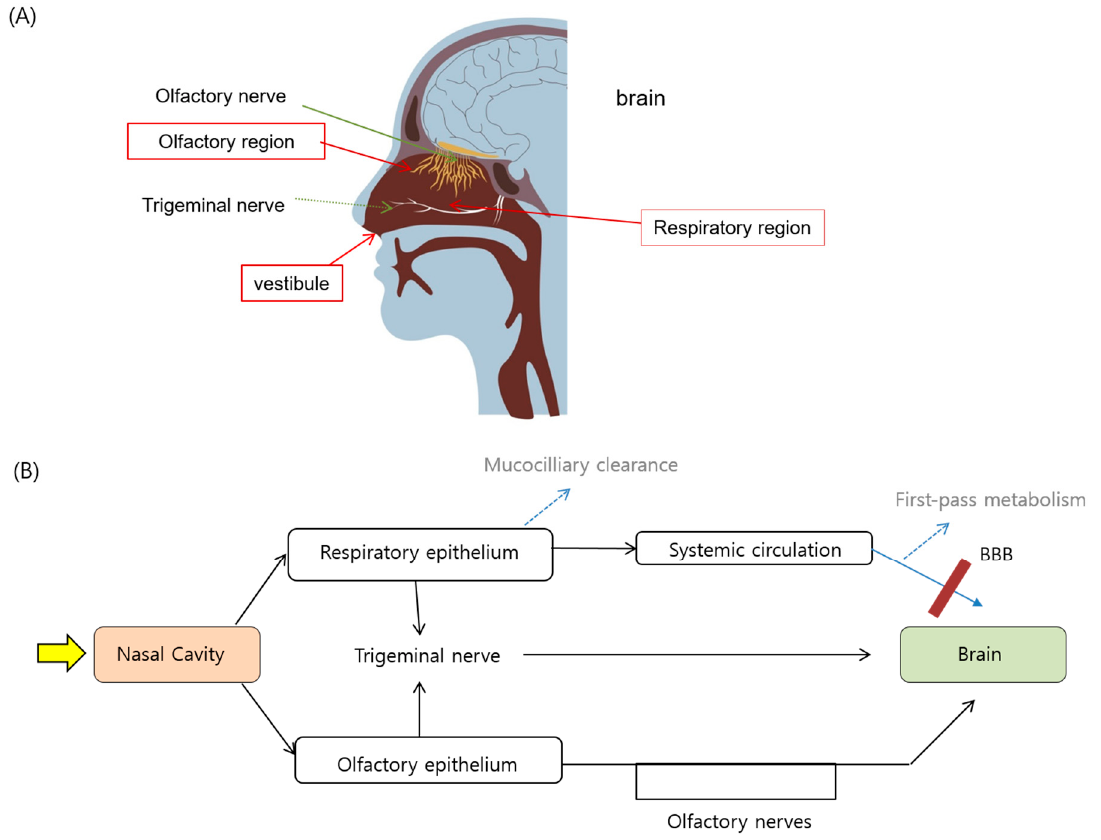
Figure 1. (A) Intranasal structure involved in the possible drug transport and ( B ) the potential drug transport routes leading to brain uptake following intranasal